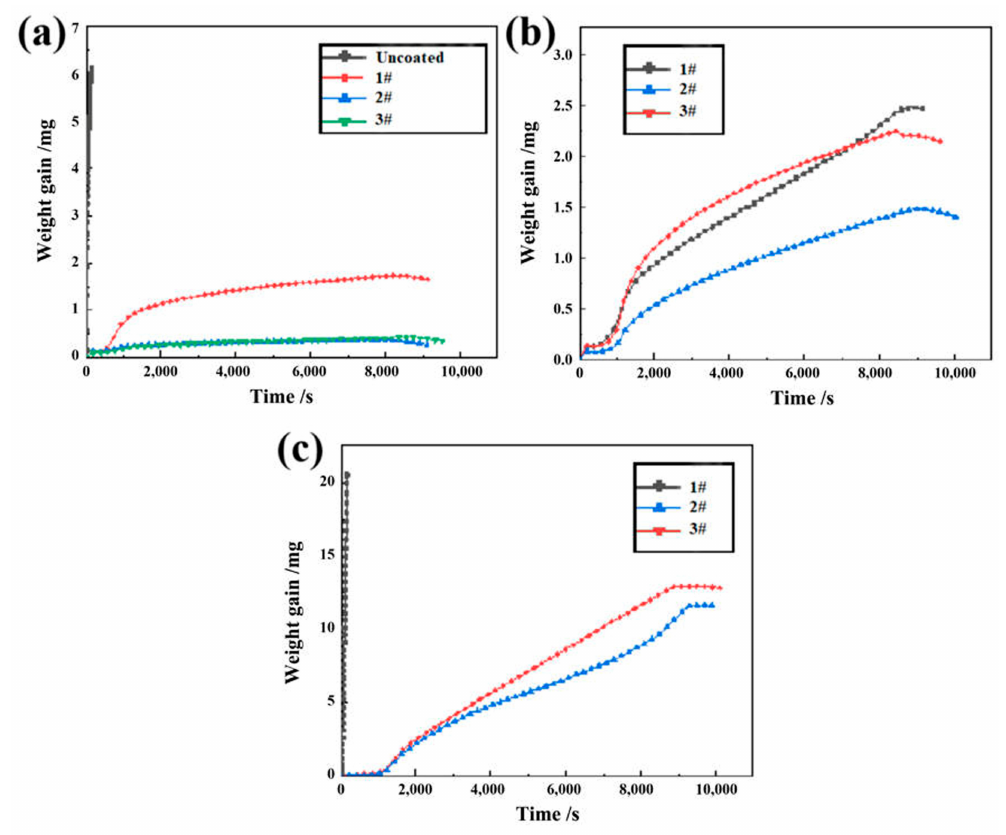
Figure 6. Thermogravimetry curves of three Cr-coating samples oxidized at ( a ) 800 ◦ C, ( b ) 1000 ◦ C and ( c ) 1200 ◦